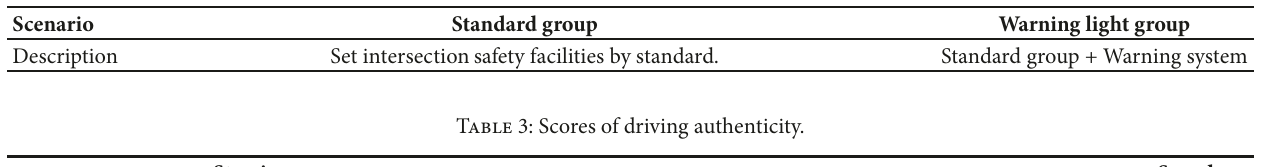
Table 2: Experiment scenario descriptions.